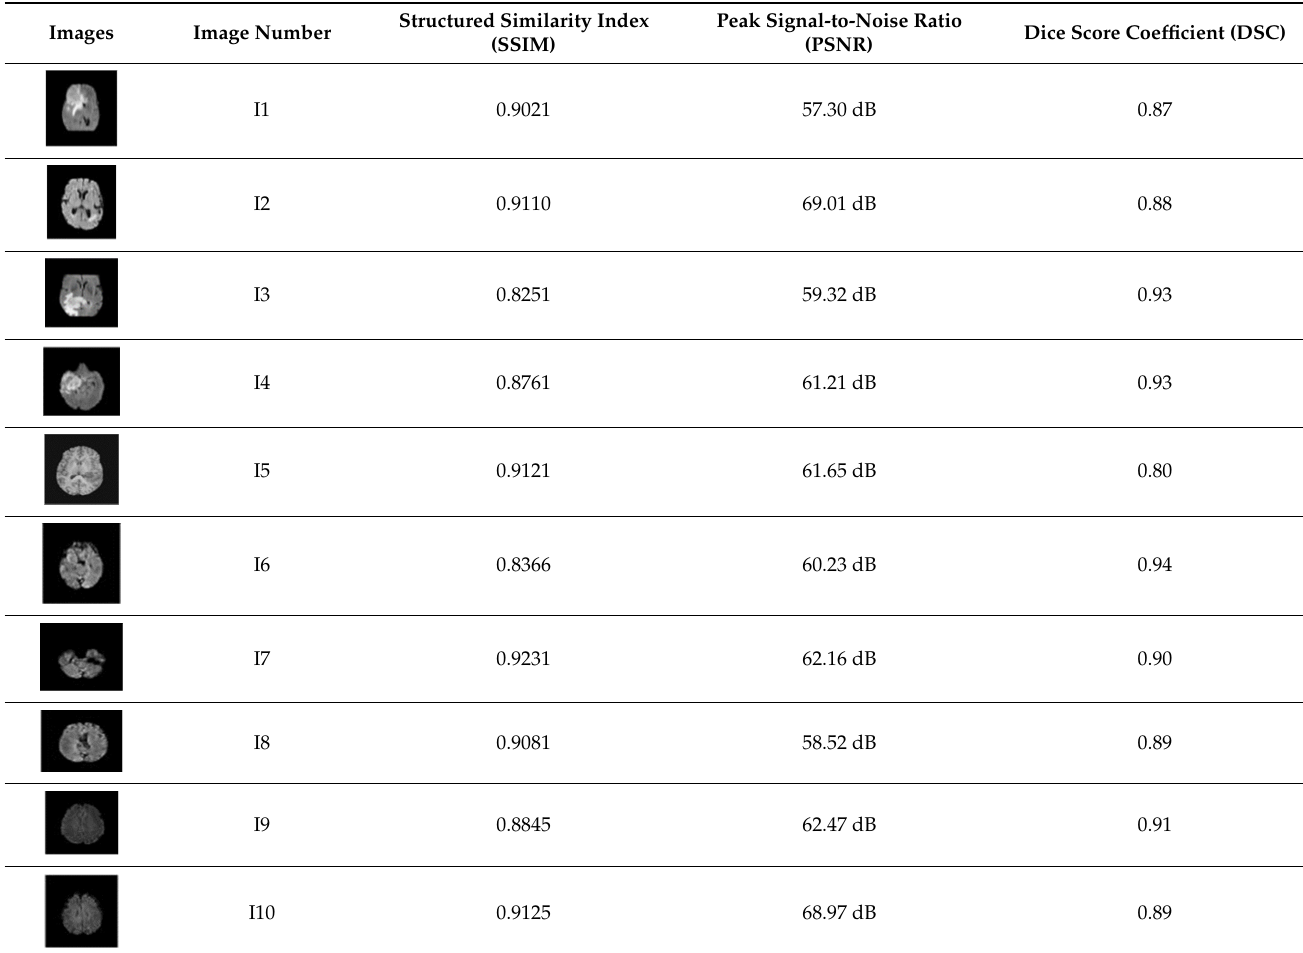
Table 3. Results using RT-GAN algorithm.